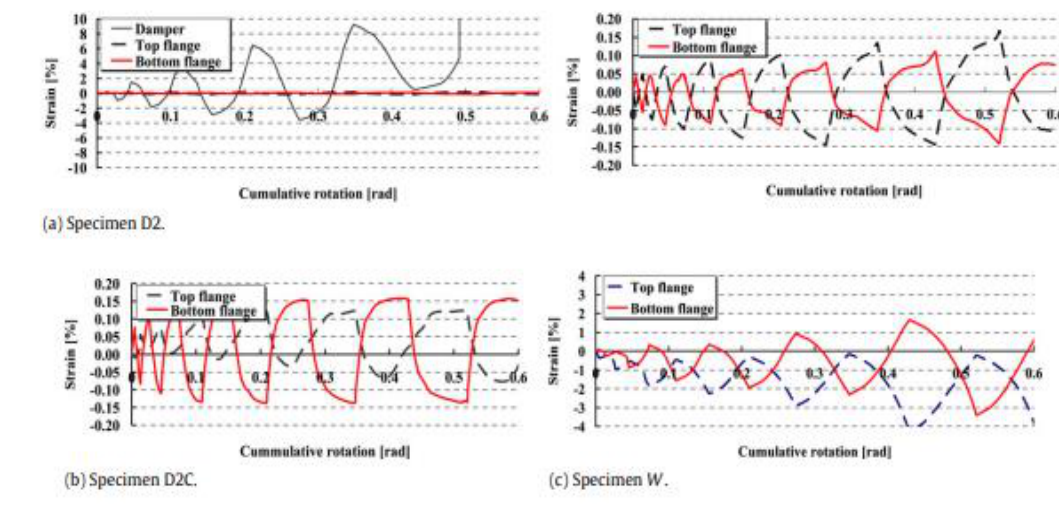
Figure 12. Strain profile of beam flange and